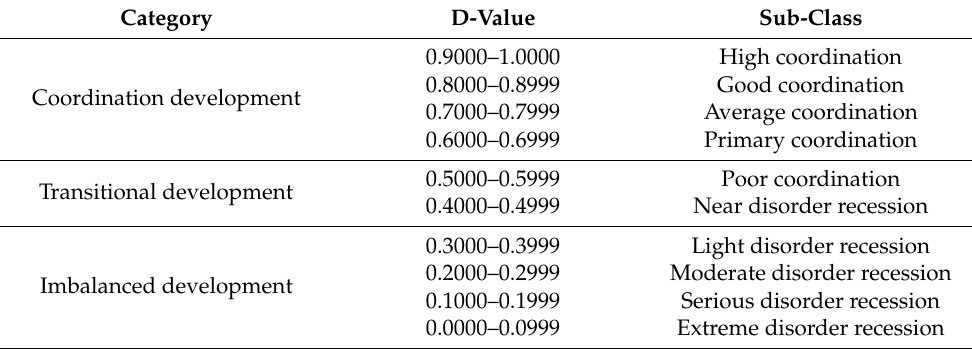
Table 1. Development classification for the urban industrial co-agglomeration and intensive land use